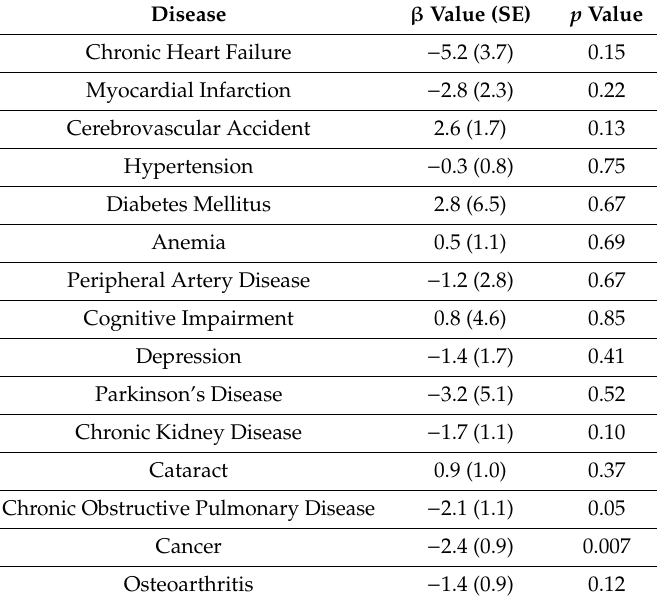
Table 4. Linear mixed e ff ect models analyzing rate of change over time in RMR (Kcal / day) in subjects with disease present at baseline as compared to RMR change in subjects that never developed the disease. The models are adjusted for baseline age, sex, baseline lean body mass, fat mass, and their rate of change over